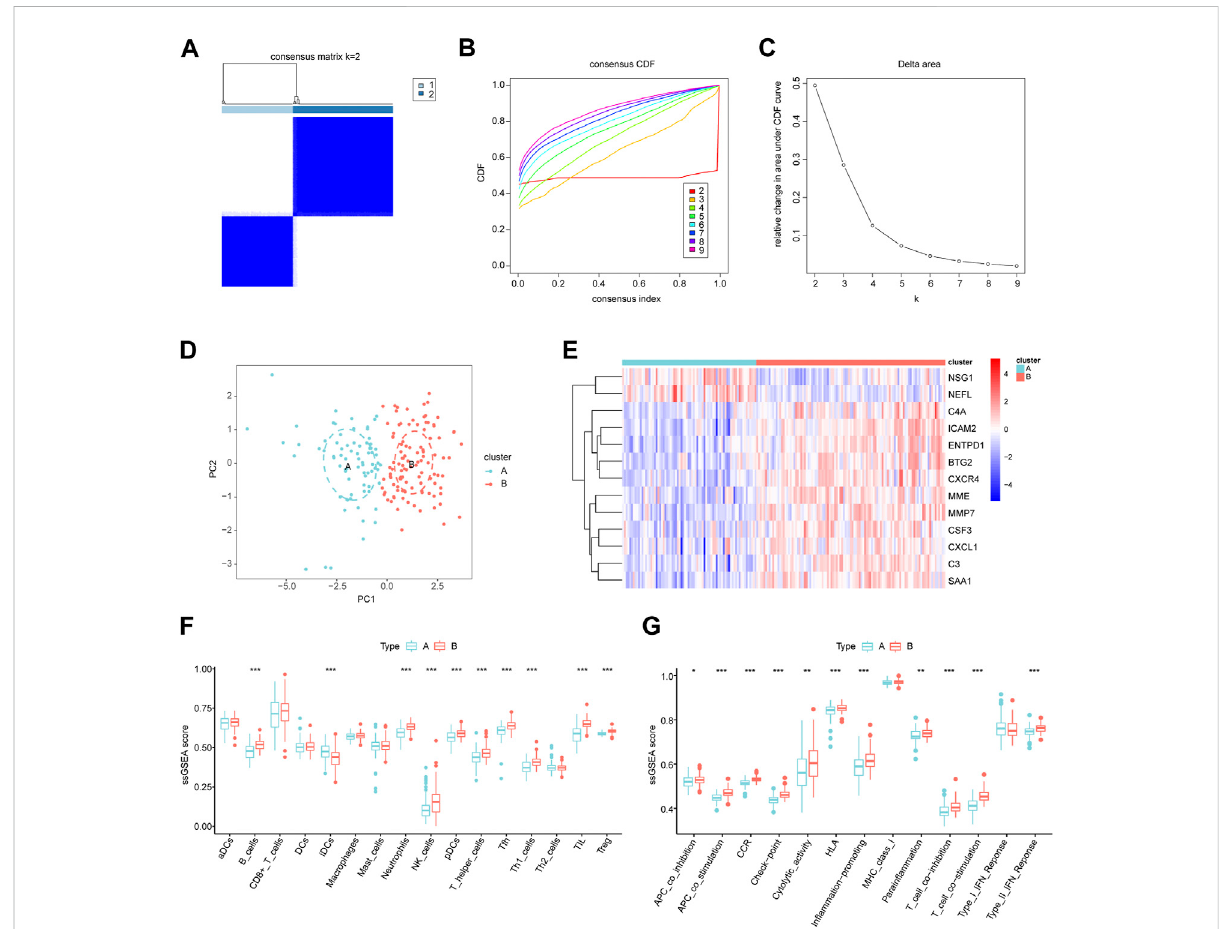
FIGURE 8 Identi fi cation of molecular subgroups in periodontitis. (A) Consensus clustering matrix when k = 2. (B) The cumulative distribution function (CDF) from k = 2 to 9. (C) Relative variation of thearea under the CDF region at k = 2 – 9. (D) The t-SNE diagram for verifying the differences between two modi fi cation subgroups. (E) Heatmap of 13 key biomarkers between two subgroups. (F,G) The differences in in fi ltrated immune cells and functions. * p < 0.05, ** p < 0.01, *** p <